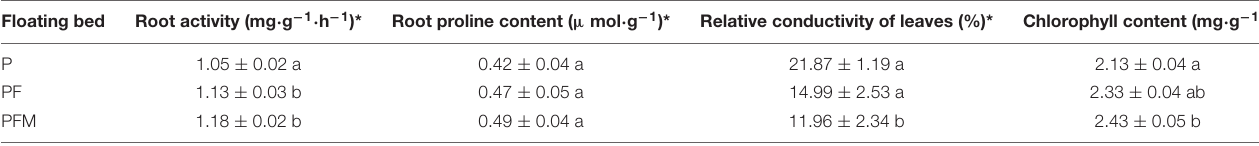
TABLE 3 | Physiological characteristics of I. pseudoacorus in the floating beds P, PF, and PFM. Floating